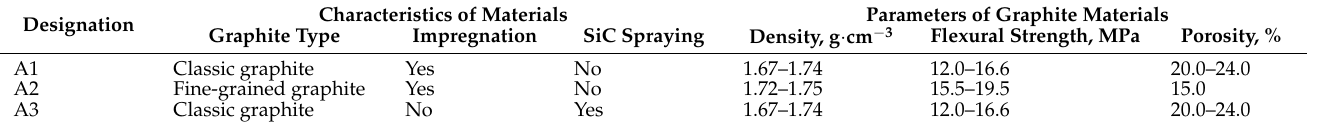
Table 3. Impeller designation and characterization of material used for rotor preparation.